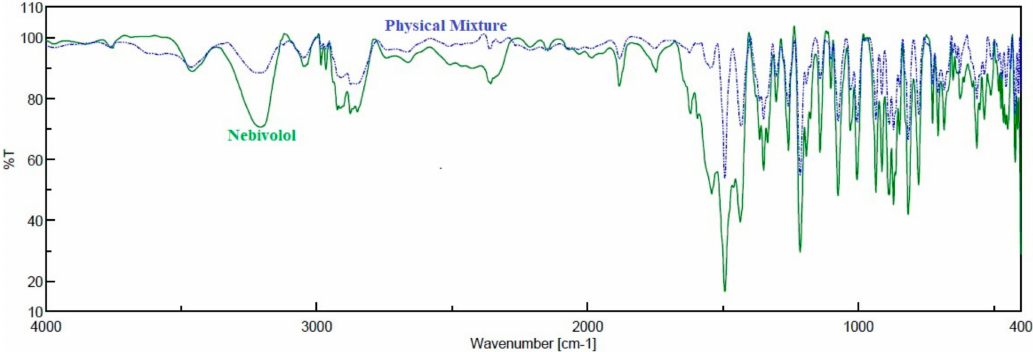
Figure 1. A representative FTIR spectra of nebivolol and physical